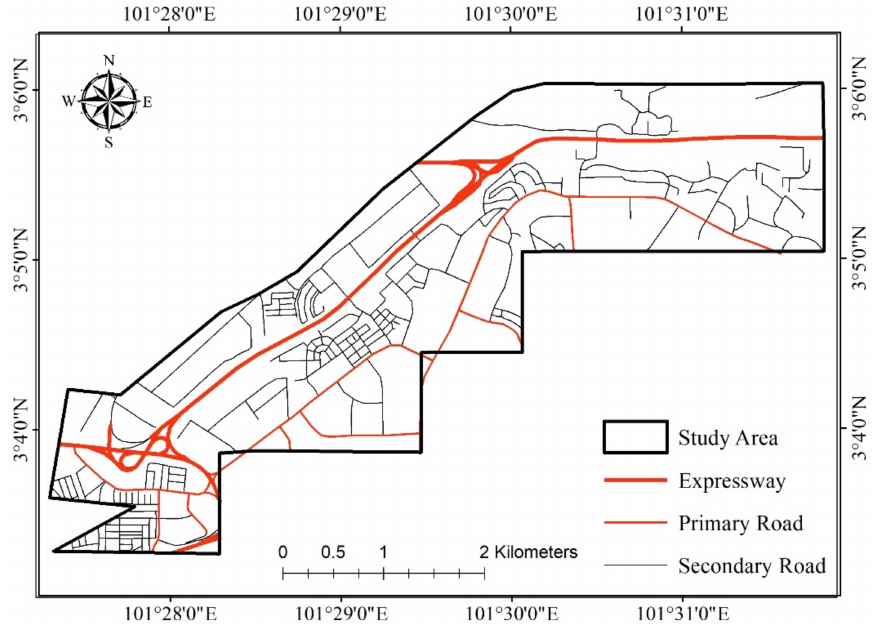
Figure 4. Type of road network such as expressway, primary, and secondary roads.